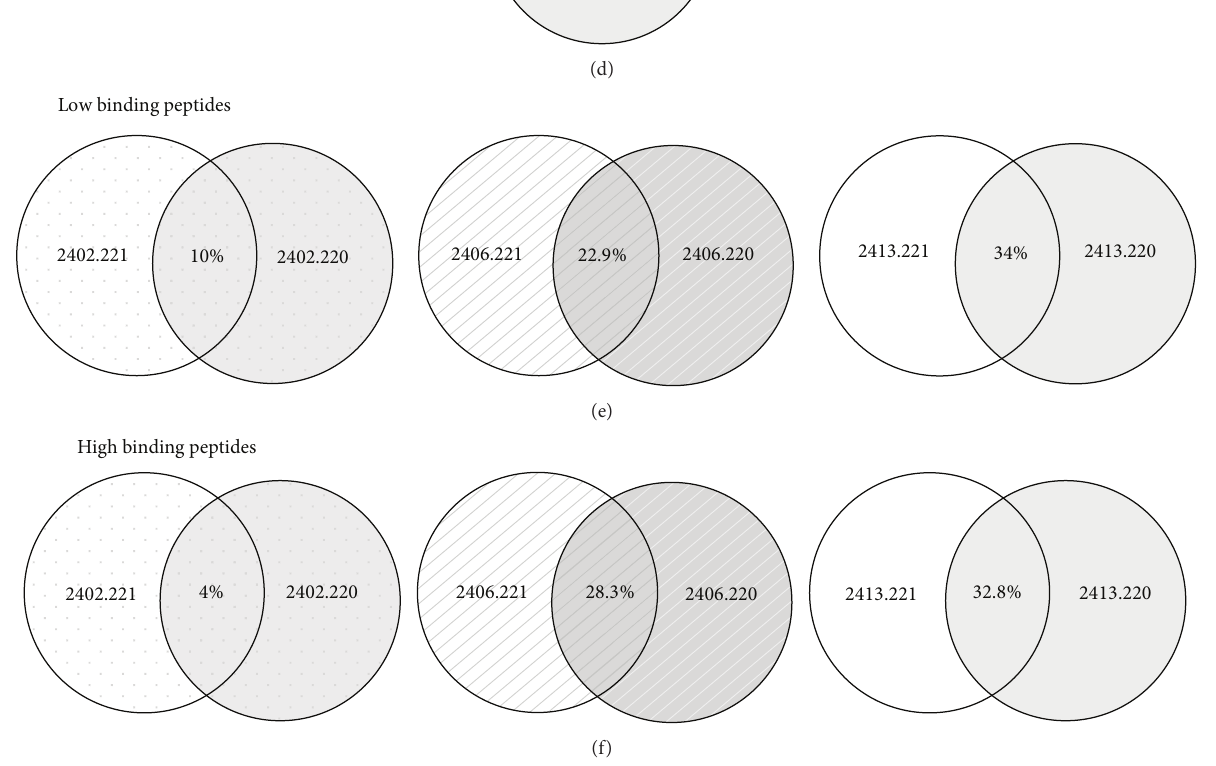
Figure 4: Shared peptides of HLA-A ∗ 24/156 allotypes. Percentages of low binding peptides shared between sHLA-A ∗ 24:02, sHLA-A ∗ 24:06, and sHLA-A ∗ 24:13 in the presence (a) or absence (b) of TPN. Percentage of high binding peptides shared between the 3 allotypes in the presence (c) or absence (d) of TPN. (e) and (f) demonstrate percentages of low and high binding peptides shared by individual sHLA- A ∗ 24/156 variants when presented in the presence and absence of TPN. sHLA-A ∗ 24/156 variants in the absence of TPN were found to share a very small percentage of their overall peptide repertoire compared to peptide repertoire shared by them in the presence of